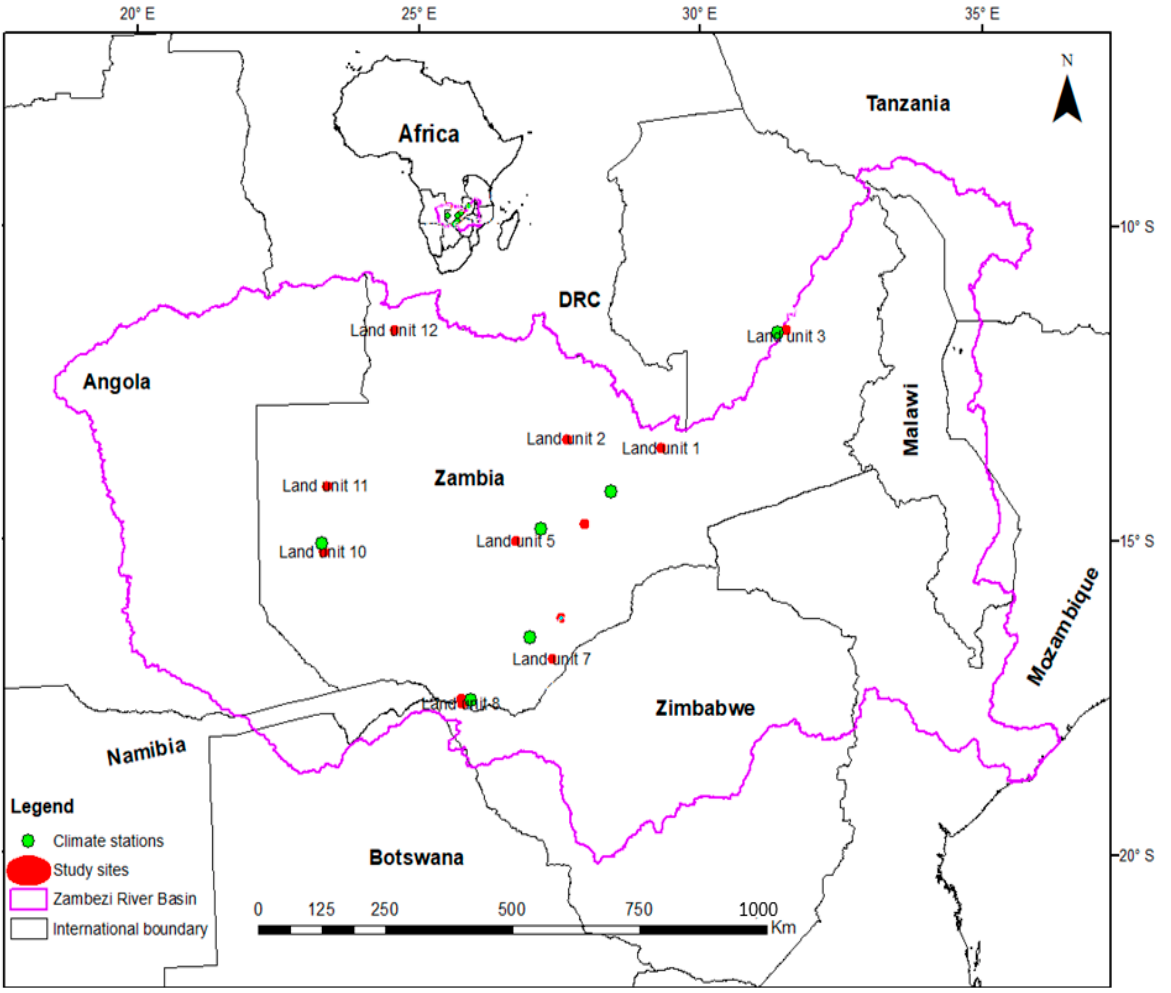
Figure 1. Location of the 12 land units and 6 meteorological stations in Zambia in the Zambezi River Basin.